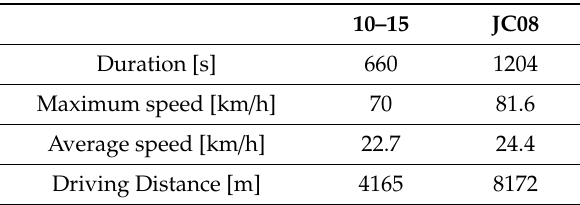
Figure 6. Driving pattern of JC08 mode. Figure 7. Torque–speed maps of the driving cycles: ( a ) 10–15 mode; ( b ) JC08 mode; ( c ) WLTC mode. Table 2. Specifications of 10–15 mode and JC08 mode.